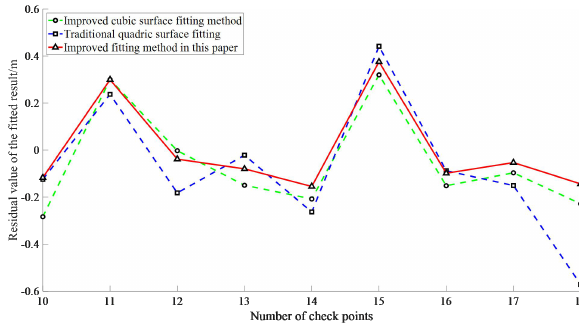
Figure 2. Results of residual error comparison between improved Vondrank filtering and traditional method Figure 2. clearly shows the comparison of the three methods. The red solid line is the improved fitting method studied in this paper. The overall trend tends to be stable, and the fitting result is better than the other two